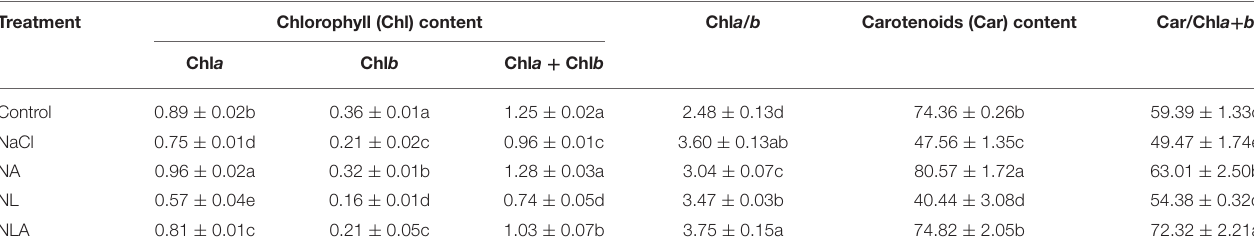
Values are means ± SD (n = 3). Different letters (a, b, c, d, and e) indicate significant difference at P < 0.05 among treatments. Note: Control, no added NaCl, no sprayed AsA and LYC; NaCl, added 100 mmol/L NaCl; NA, added 100 mmol/L NaCl and sprayed 0.5 mmol/L AsA; NL, added 100 mmol/L NaCl and sprayed 0.25 mmol/L LYC; NLA, added 100 mmol/L NaCl and sprayed 0.25 mmol/L LYC and 0.5 mmol/L